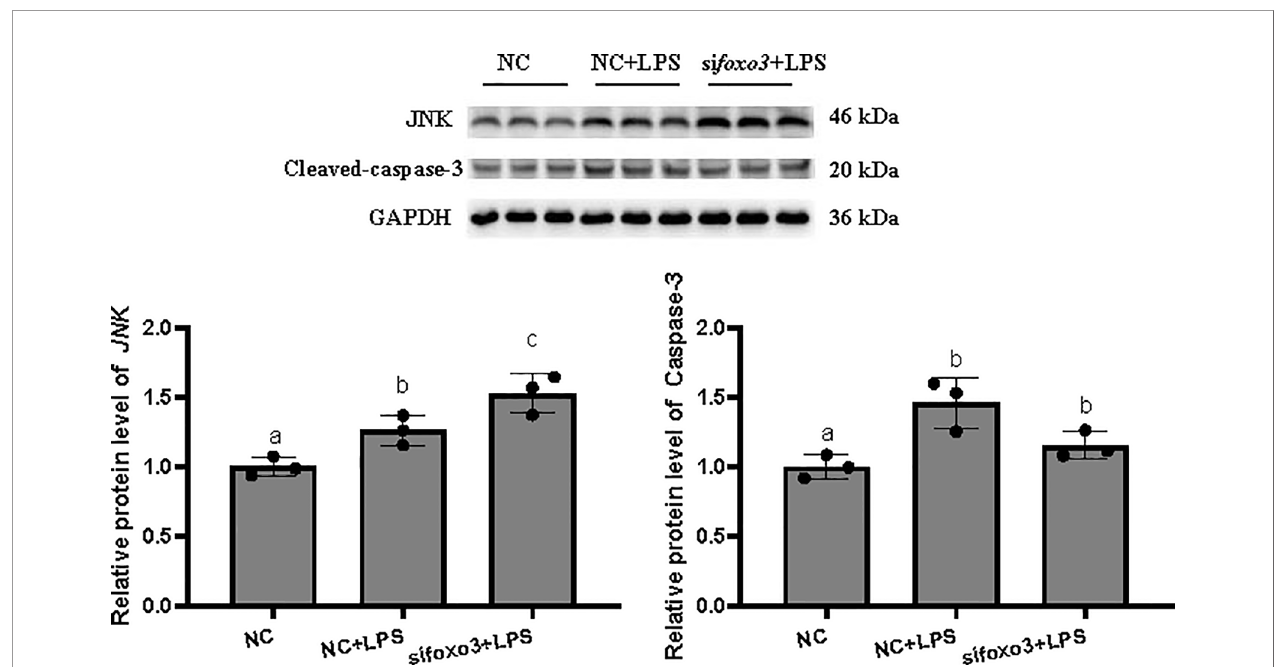
FIGURE 5 | Protein levels in turbot hepatocytes. The relative protein abundances of JNK and cleaved-caspase-3 in hepatocytes were measured by western blot and expressed as relative expression values to those in NC group. Values are represented as the mean ± standard deviation (n = 3). Values with different letters mean signi fi cantly difference ( P <